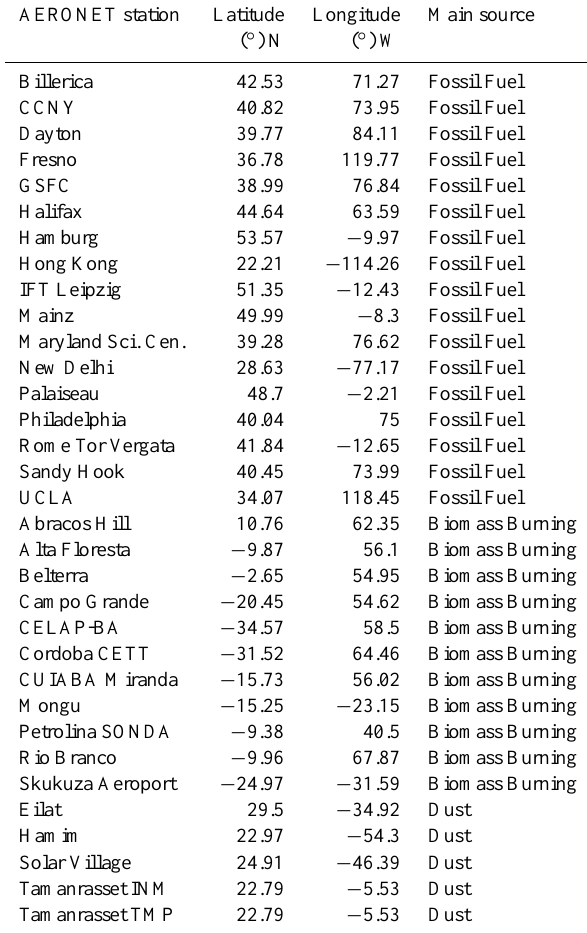
Table 1. List of the AERONET stations around the world with dom- inant sources used for the creation of the Ångström